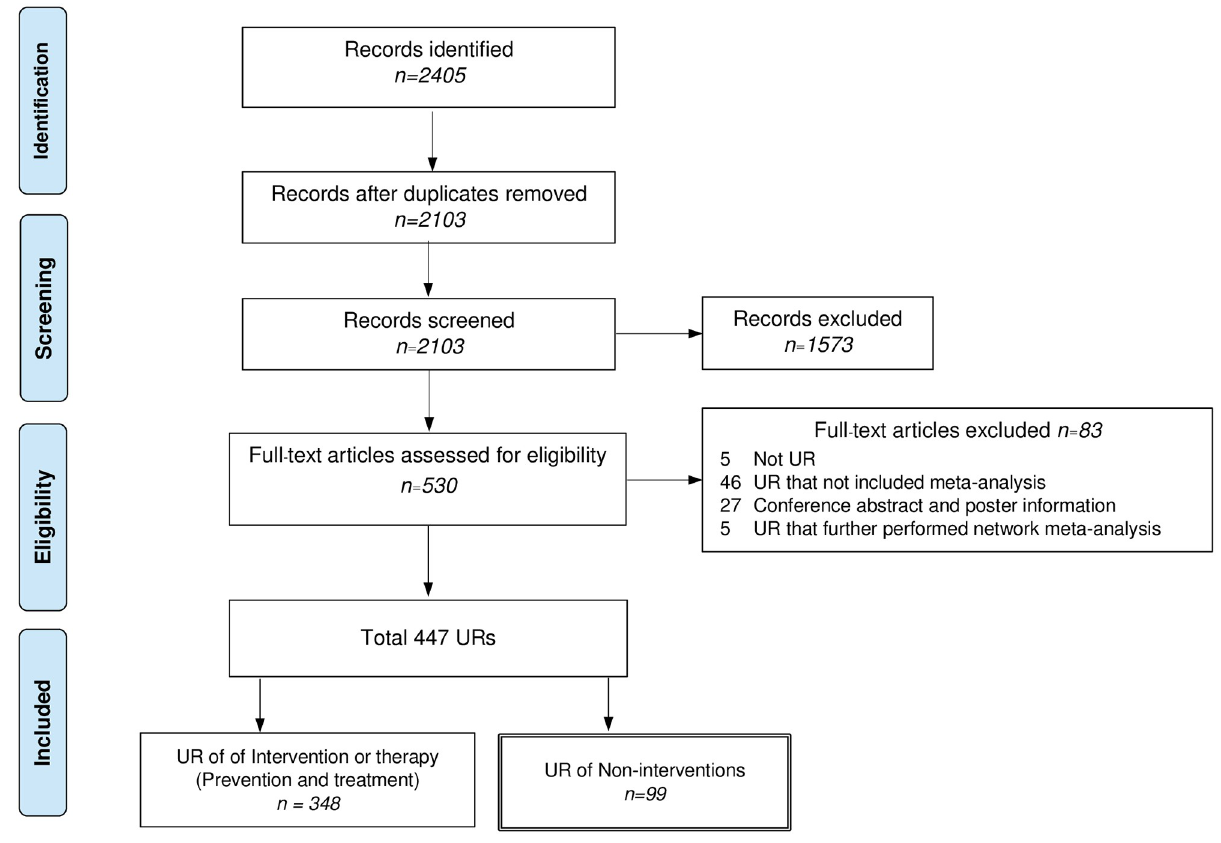
Fig 1. Evidence search and